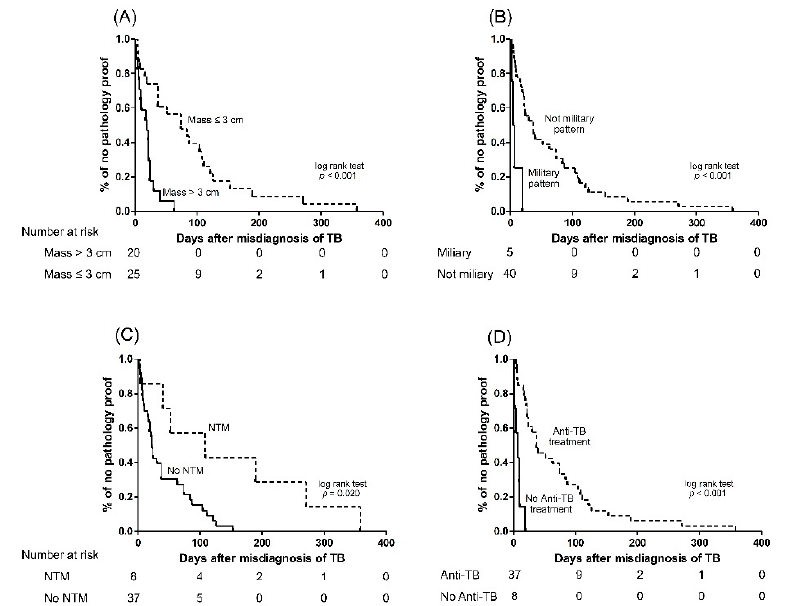
Figure 4. Kaplan–Meier curves for time to obtain pathology proof of lung cancer according to ( A ) lesion size, ( B ) radiographic miliary pattern, ( C ) mycobacterial culture, and ( D ) anti-tuberculosis treatment. NTM, nontuberculous mycobacteria; TB, tuberculosis.